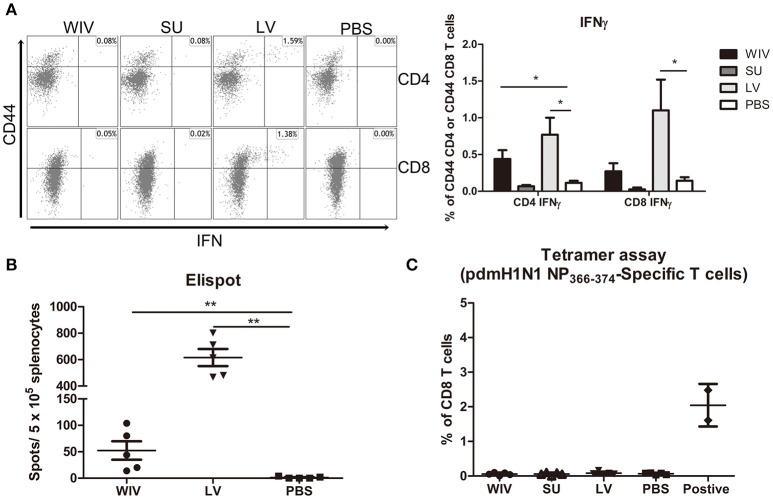
Influenza-specific T cell immune responses induced by sequential infection or immunization. (A) Splenocytes harvested on day 28 post the second infection/vaccination, were stimulated with A(H1N1)pdm09 WIV and anti-CD28 overnight in presence of protein transport inhibitor. Presence of intracellular IFNγ in CD4+CD44+ and CD8+CD44+ T cells was analyzed by flow cytometry. Left: representative dot plots of stimulated CD4 or CD8 T cells stained for CD44 and IFNγ. Right: percentages of IFNγ-producing cells among CD4+CD44+ and CD8+CD44+ T cells. (n = 4 or 5, representative of two experiments, Mann-Whitney U-test, *p < 0.05). (B) On day 28 post the second infection/immunization, NP366−374 of PR8 virus was used to stimulate mouse splenocytes and IFNγ-producing CD8 T cells were enumerated by ELISPOT. (n = 5, Mann-Whitney U test, **
p < 0.01). (C) A(H1N1)pdm09 NP366−374-specific CD8 T cells in spleens of infected/immunized mice (n = 5) were determined by tetramer assay. Lymphocytes from the blood of mice (n = 2) infected with A(H1N1)pdm09 virus served as positive control.